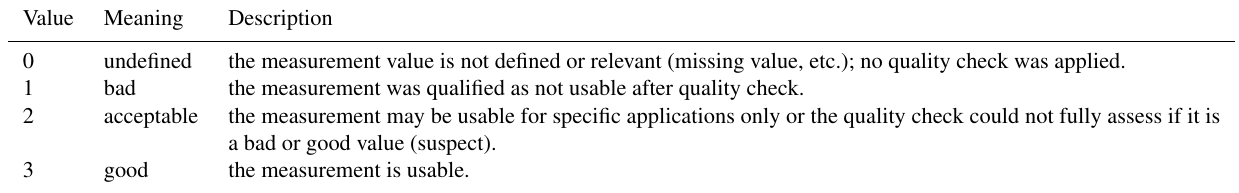
Table 2. Quality levels defined for Sea State CCI dataset